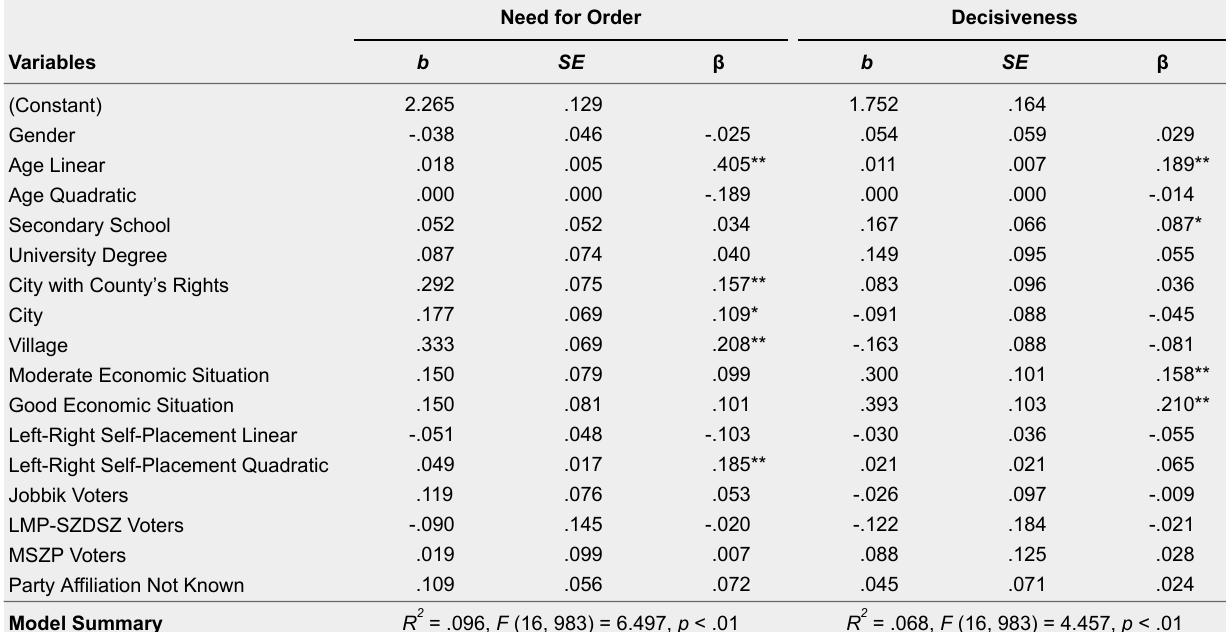
Multiple Regression Analyses After the Second Set of Predictors (Political Predictors) Were Added to the Model. Dependent Variables: Need for Order and Decisiveness (N = 1000) DecisivenessNeed for